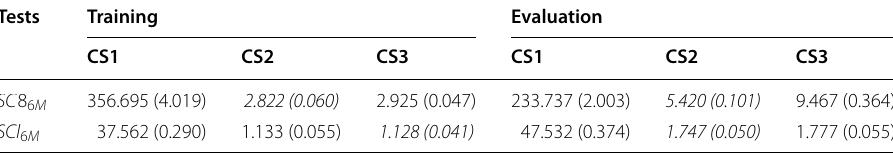
The values in parenthesis are the standard deviation values Italic : lowest computation time for a given caching